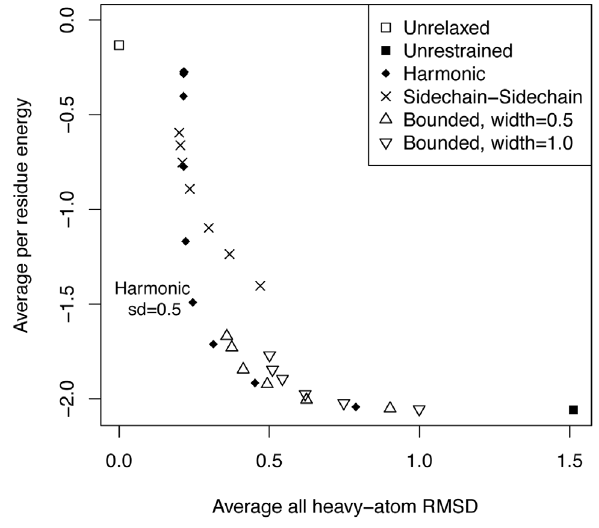
Figure 1 . Restraint-protocol evaluation. Average all-atom RMSD to the original structure versus per residue energies across the 51 protein test set for relax runs using different restraint parameters. The relax protocol conducts cycles of sidechain repacking and all-atom minimi- zation while ramping the repulsive energy up and down – the protocol without additional restraints is the ‘‘unrestrained’’ set. The harmonic set adds all-atom restraints using a harmonic potential with a width specified by the sd parameter. The bounded sets employ restraints with a zero value within a set ‘‘width’’ parameter and a linear value specified by an sd term further from the origin. The sidechain-sidechain restraints place harmonic restraints between pairs of sidechain atoms at a specified cutoff distance, which can be varied to produce more or less restrictive restraints.